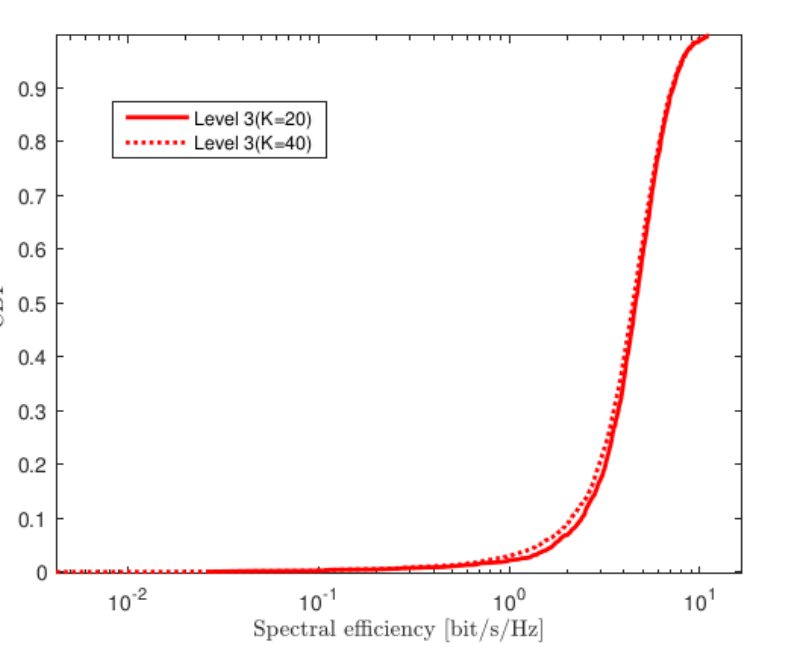
Figure 6. The SE comparison of different number of